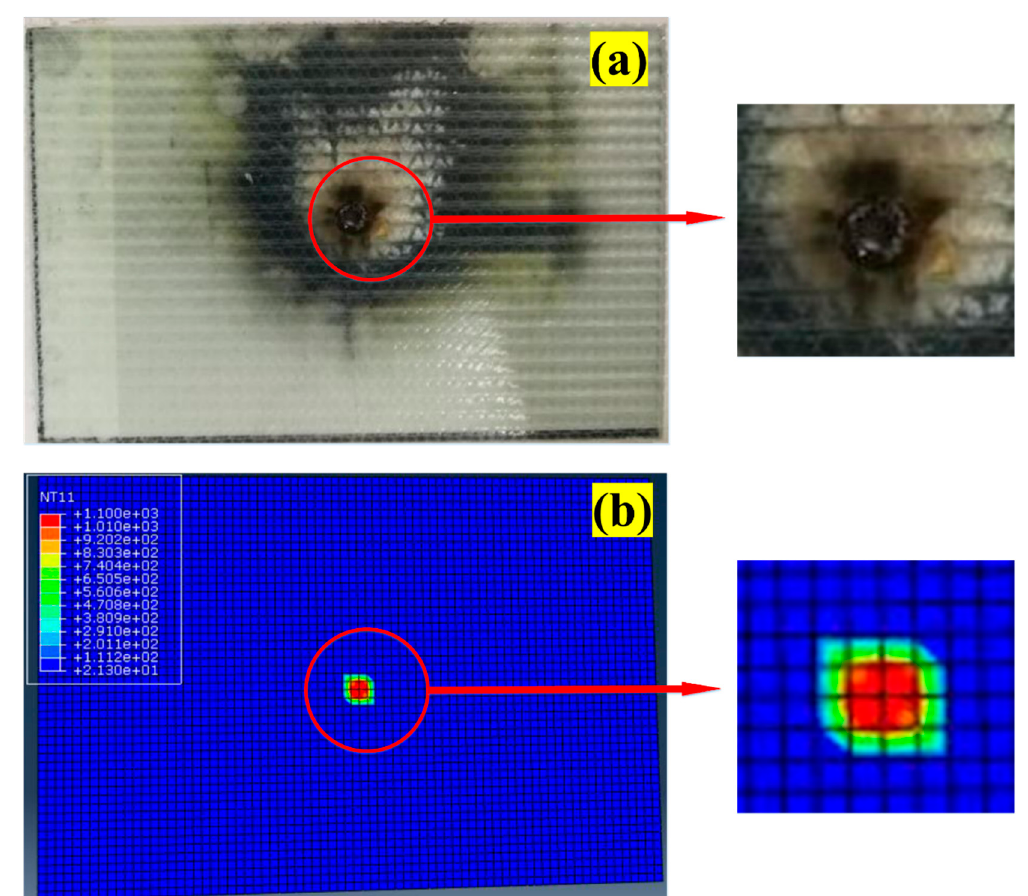
Figure 21. Comparison of ablation damage obtained by the simulation and experiment, ( a ) experimental result, ( b ) simu- lation result.